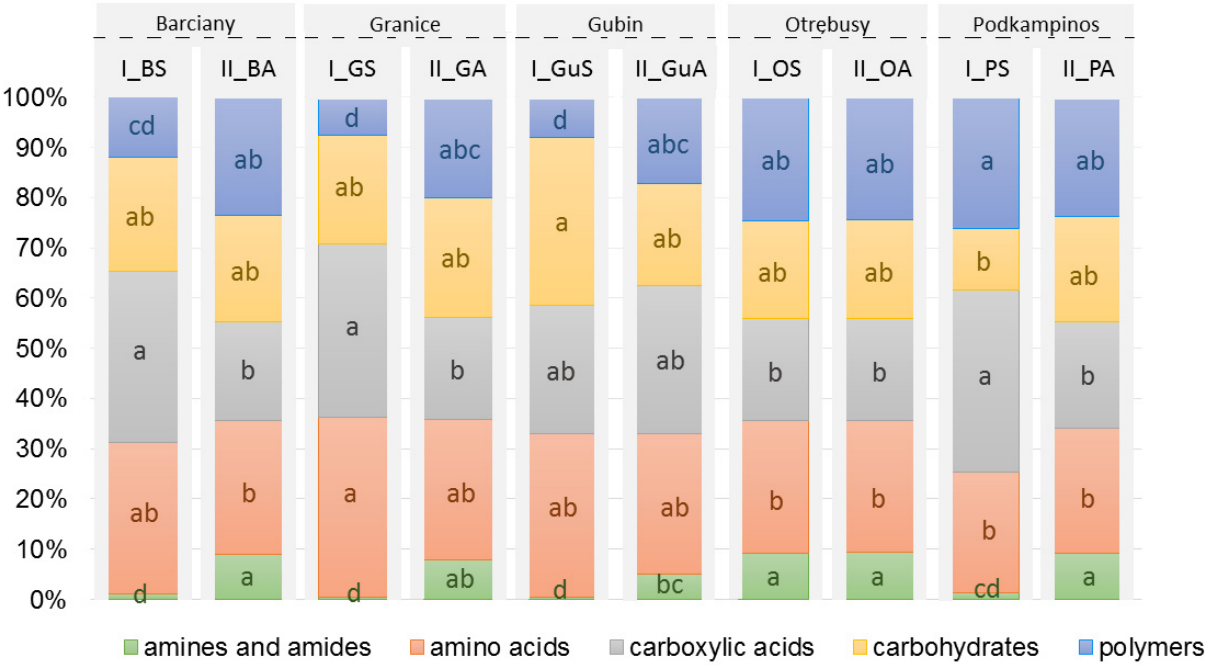
Figure 1. Heat map of the carbon sources utilisation patterns based on the average absorbance values after 168 h of incubation.